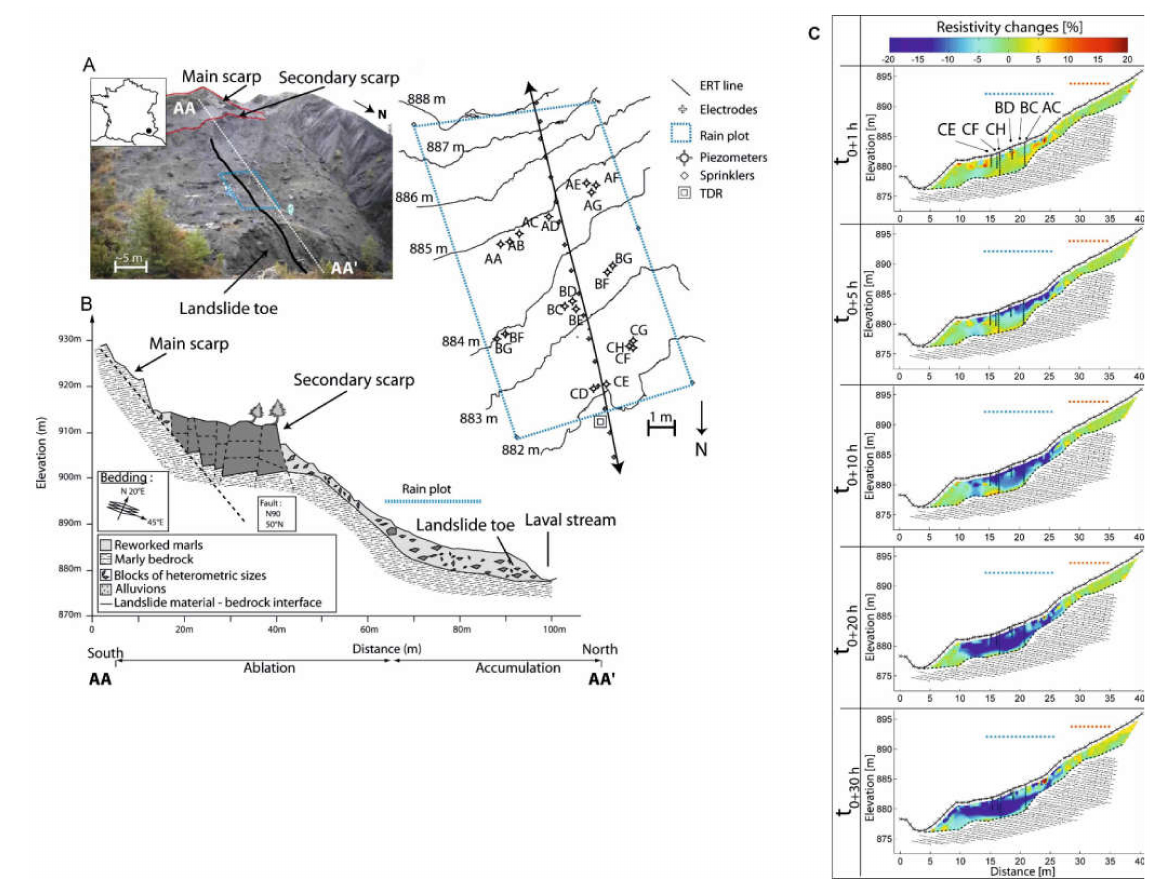
Figure 3. ( A ) Laval landslide (ORE Draix, South French Alps) with location of the ERT line and of the equipment used for the rain experiment. ( B ) Cross section of the landslide. ( C ) Resistivity changes during the rain experiment (after